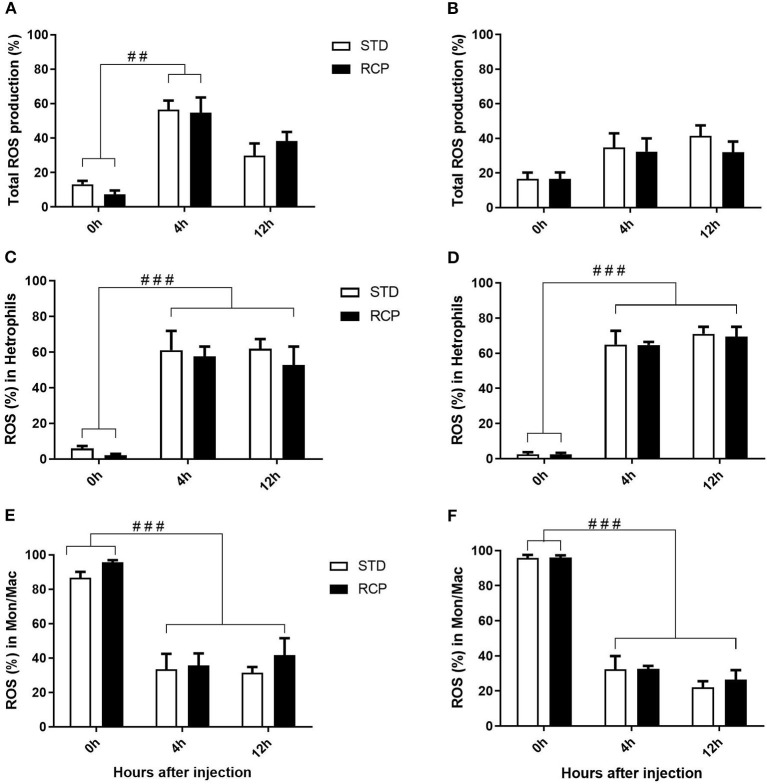
Impact of reduced crude protein diet on ROS production in abdominal leukocytes following an in vivo zymosan challenge. Total percentage of ROS producing cells are shown following in vivo challenges on day 14 (A) or 35 (B). Higher resolution evaluation shows ROS production among distinct phagocyte subsets [heterophil d14 (C) and d35 (D); monocyte/ macrophages d14 (E) and d35 (F)] (n = 5 for time 0 and 12, and n = 6 for time 4 H). ##P < 0.01 and ###P < 0.001 among different time points. RCP, Reduced Crude Protein; STD, Standard diet.